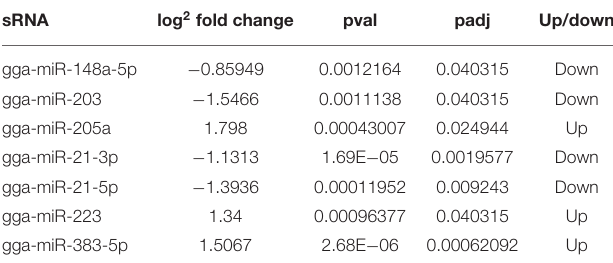
TABLE 3 | Expression of seven differentially expressed miRNAs in ALV-J-infected chickens and uninfected chickens.